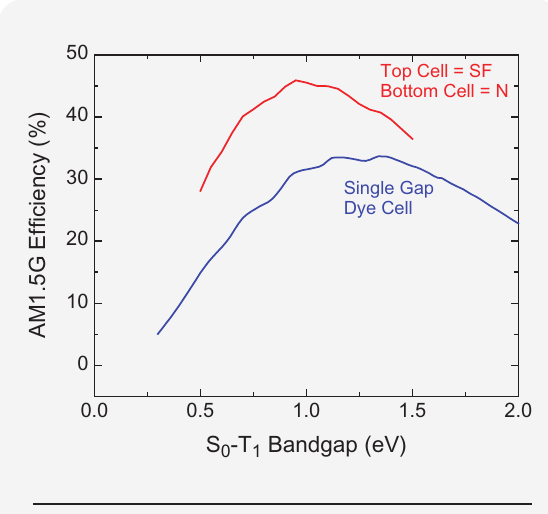
Figure 4. Maximum theoretical effi ciency of a single-gap photovoltaic solar cell as a function of S 0 -T 1 bandgap. Blue, without, and red, with a singlet fi ssion layer, assuming full absorption of incident solar light above 1.1 eV. Reproduced with permission from J. Appl. Phys.